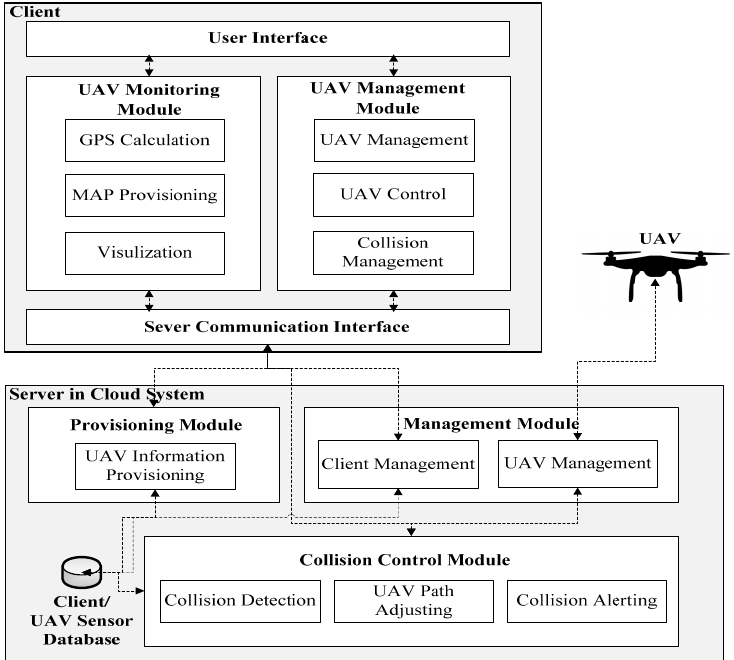
Figure 1. System Architecture of UAV Flight Tracker.